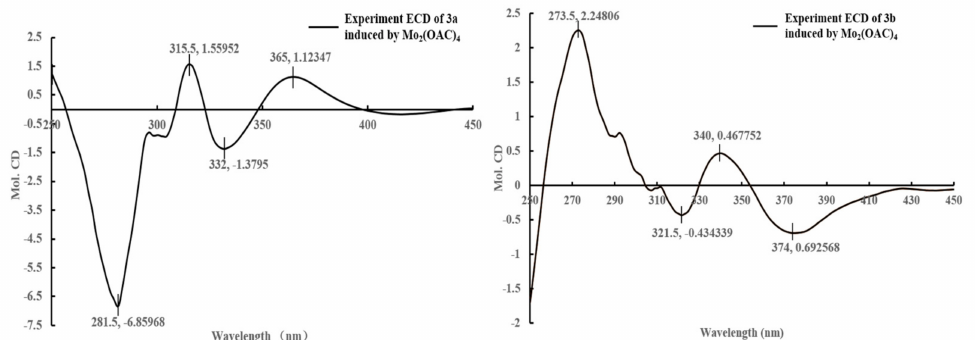
Figure 5. The CD spectrum of compounds 3a and 3b induced by Mo 2 (OAC) 4 (dimolybdenum tetracetate) (the inherent CD of the diol was